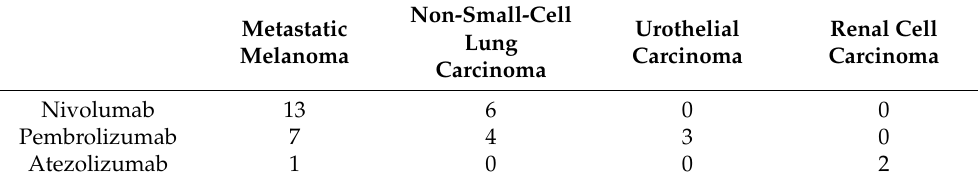
Table 1. Rheumatological adverse events specific to cancer type.